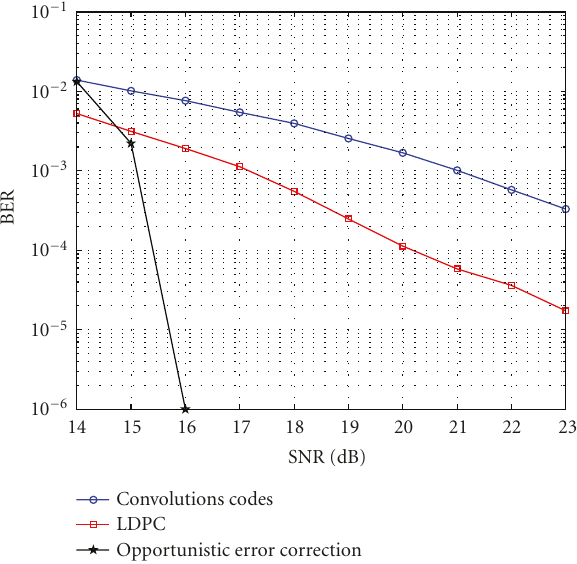
Figure 10: FEC layers comparison over channel model A with the same e ff ective transmission data rate 21.6 Mbits/s (i.e., PER = 10%, BER = 2 × 10 − 4 ). The SNR is in the time domain and the channel estimation is assumed to be perfect. The blue circle points are for convolutions codes; the red square points are for LDPC codes from 802.11n and the black star points are for opportunistic error correction layer (Fountain codes + LDPC plus CRC). For SNR = 16dB and higher, no errors are detected in the opportunistic error- correction layer. So, for SNR = 16dB, we represent BER = 0 by 10 − 6 .